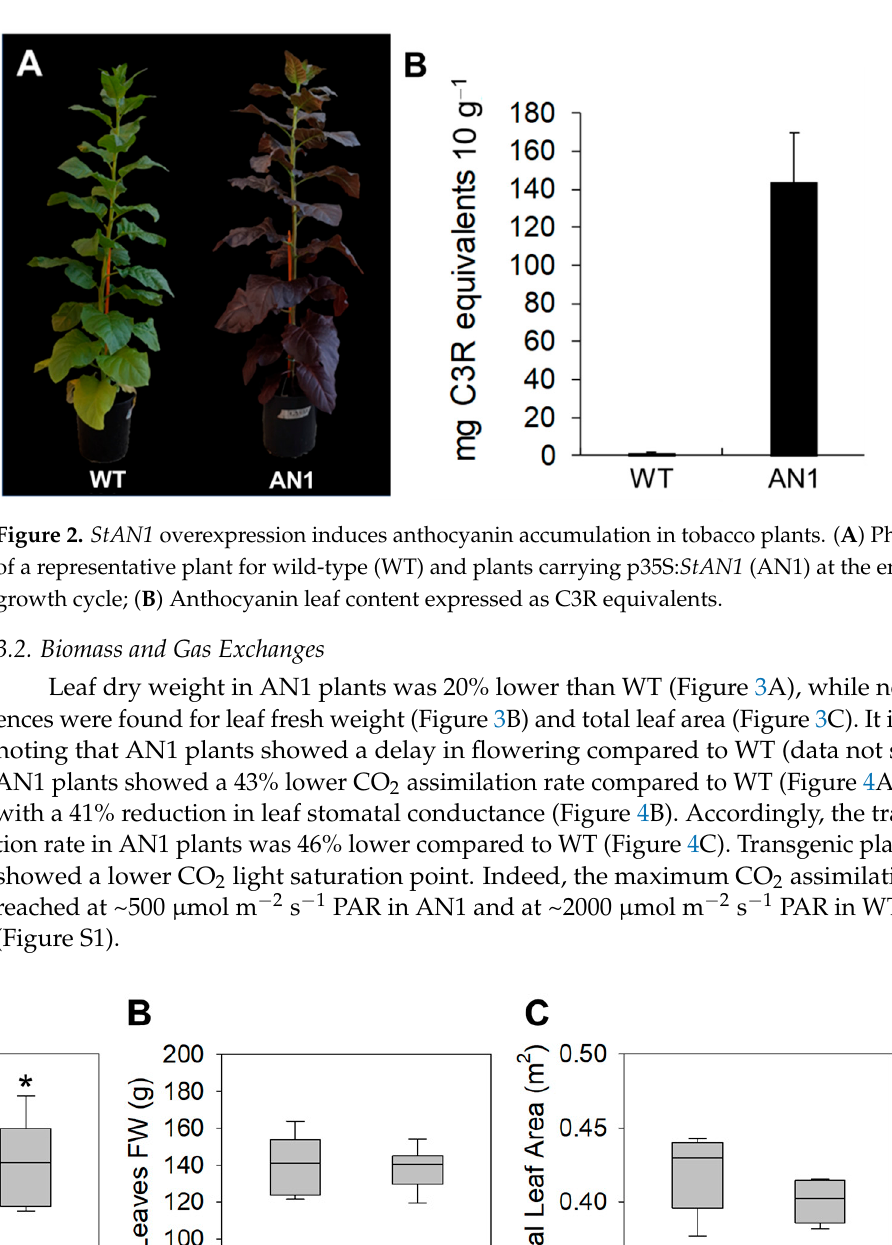
Figure 3. Biometric parameters in AN1 and WT plants. ( A ) Leaves dry weight (DW); ( B ) Leaves fresh weight (FW); ( C ) Total leaf area. Asterisks indicate significant differences according to ANOVA (* p < 0.05).